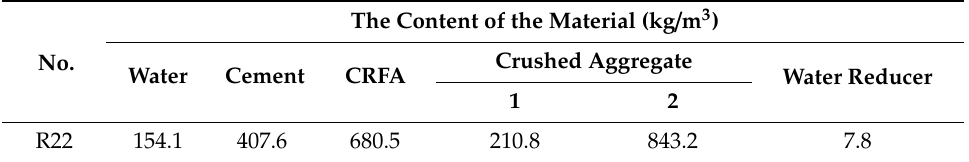
Table 9. Material consumption for 1 m 3 of the CRFA concrete (mix proportion